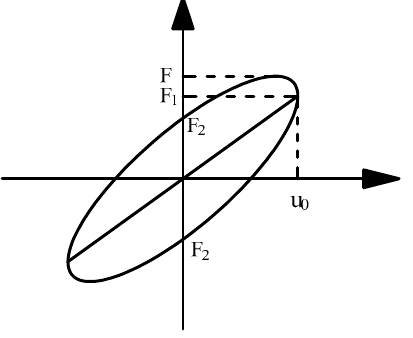
Figure 4. Force–displacement hysteresis curve.